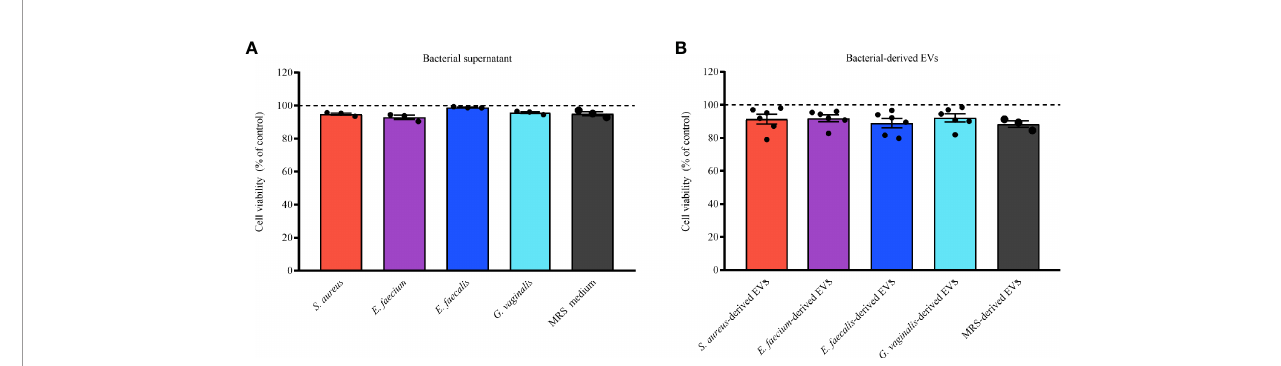
FIGURE 4 | Cell viability of cells treated with bacterial supernatants or EVs. MT-4 cells were treated or not treated for 3 days with bacterial supernatants (0.5%) or EVs (1×10 10 EVs/mL) derived from S. aureus , E. faecium , E. faecalis , and G. vaginalis . MRS medium or particles derived from MRS were used as controls. The numbers of viable and dead cells were counted according to orange acridine/propidium-iodide-based assay. Results are expressed as percentages of cell viability in EV-free or EV-treated cells. Presented are means±SEM from fi ve independent measurements. Cell viability in presence of bacterial supernatants (A) or EVs (B) derived from S. aureus , E. aecium , E. faecalis , and G. vaginalis is shown. Results are expressed as percentages of viable cells treated or not treated with bacterial supernatant or EVs. Presented are means±SEM from at least three independent